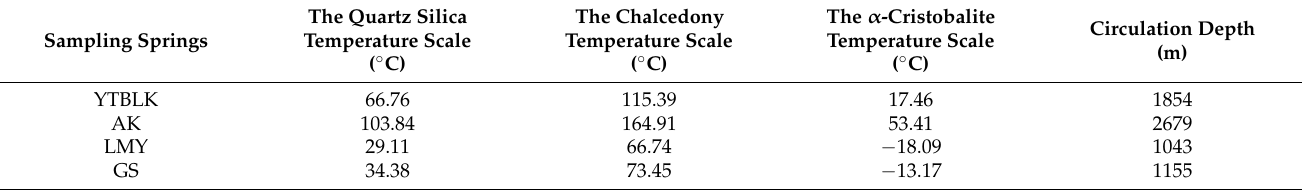
Table 3. Thermal storage temperature and circulation depth of hot springs in the study